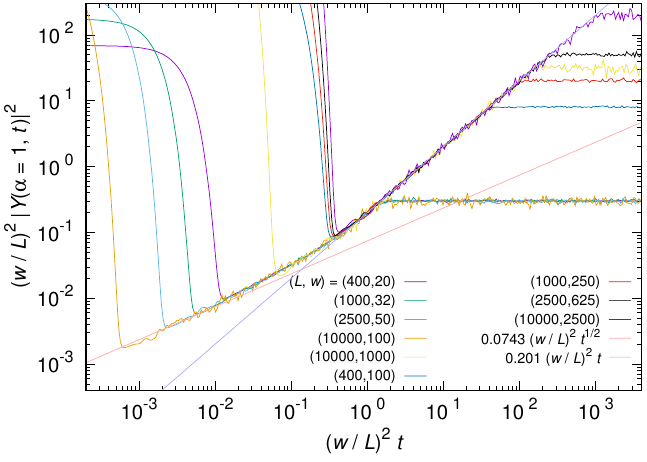
Figure 27 . The value of ( w=L ) 2 j Y ( (cid:11) = 1 ; t ) j 2 plotted against ( w=L ) 2 (cid:1) t for various ( L; w ) satisfying p L (cid:20) w (cid:20) L= 4, (cid:11) = 1. The number of samples with each value of w is 10 6 =L = 2500 ; 1000 ; 400 ; 100 for L = 400 ; 1000 ; 2500 ; 10000 cases. For w (cid:28) L= 4 the initial growth indicates that j Y ( (cid:11) = p 1 ; (cid:28) ) j 2 (cid:24) ( L=w ) t , while for all ( L; w ) plotted, the growth for larger t before the plateau agrees with j Y ( (cid:11) = 1 ; t ) j 2 (cid:24) t